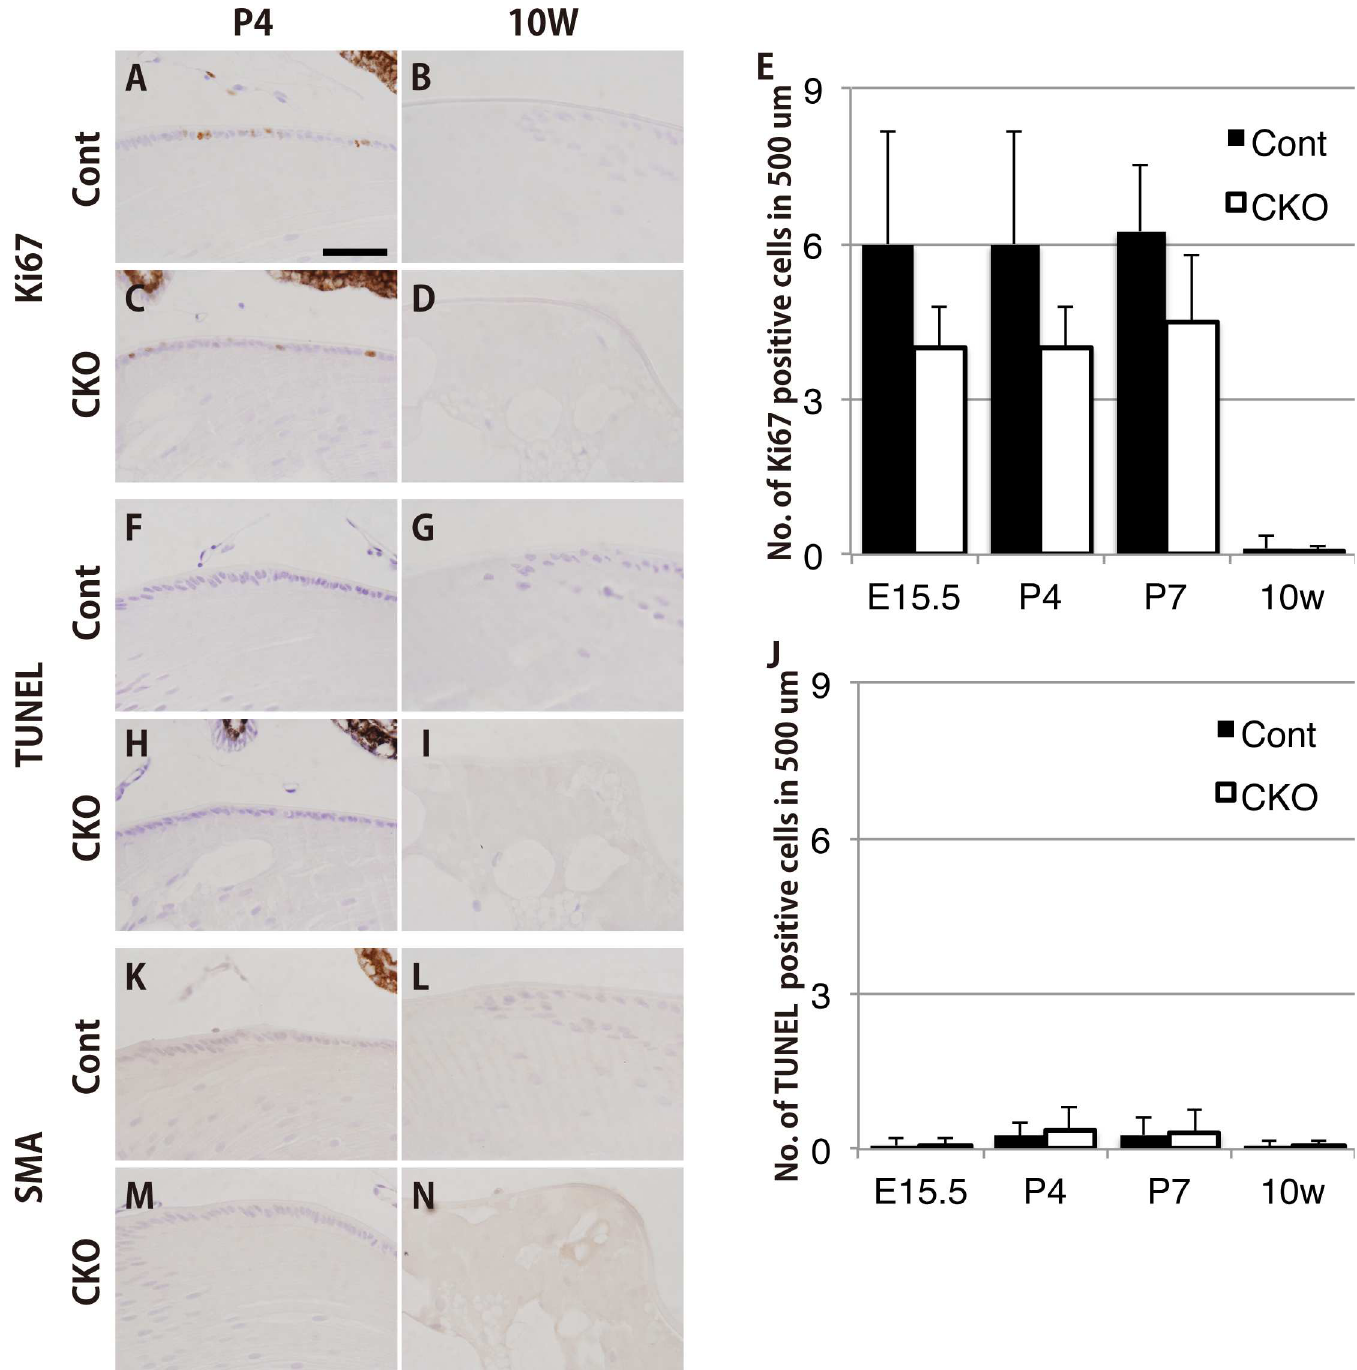
Fig 4. Cell proliferation, apoptosis,and cataractmarkerproteinexpressionin Rest –deficient lenses in vivo . (A-E)An immunohistochemicalanalysis of Ki67-positive proliferatingcells. No significantdifferences were observedin the distribution of Ki67-positive cells in the surface layer of the lens capsule, regardless of their genotypes (A-D).Althoughnot statisticallysignificant,the numberof Ki67-positive cells/lengthin the surface layer of the lens capsule of Rest CKO mice was slightly lower than that of theircontrollittermates(E). (F-J)A histological analysisof TUNEL-positive apoptoticcells. Almost no TUNEL- positive cells were detectedin the surface layer of the lens capsule, regardless of their genotypes (F-I).No significantdifference was observedin the numberof TUNEL-positive cells between Rest CKO mice and theircontrollittermates(J).(K-N)Immunohistochemical stainingfor the proteinsknown to be associated with age-related cataractsin humans. Virtuallyno SMA-positive cells were detectedin the surface layer of the lens capsule, regardlessof their genotypes. The scale bar represents 50 μ m.